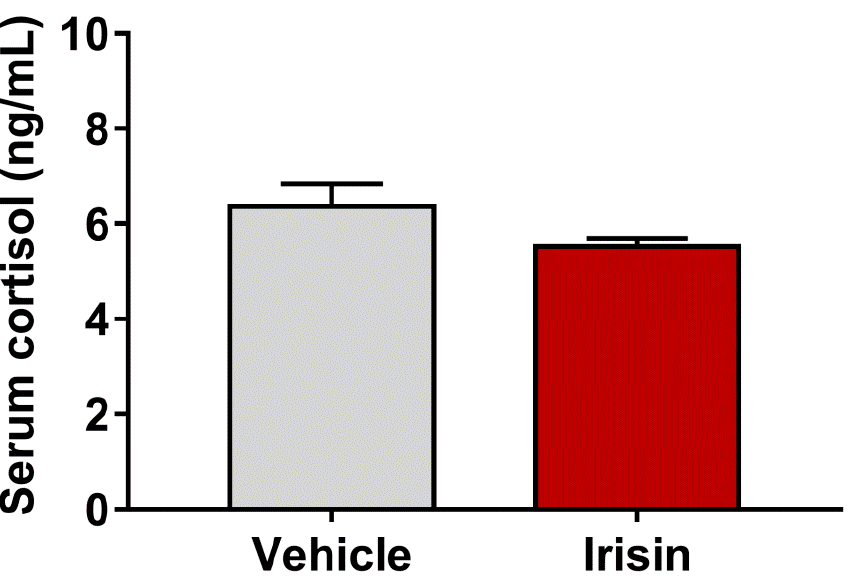
Figure 3. Concentrations of serum cortisol in irisin-treated mice and controls. Histograms represent mean values ± SEM. Results were analyzed with unpaired two-tailed Student’s t -test.